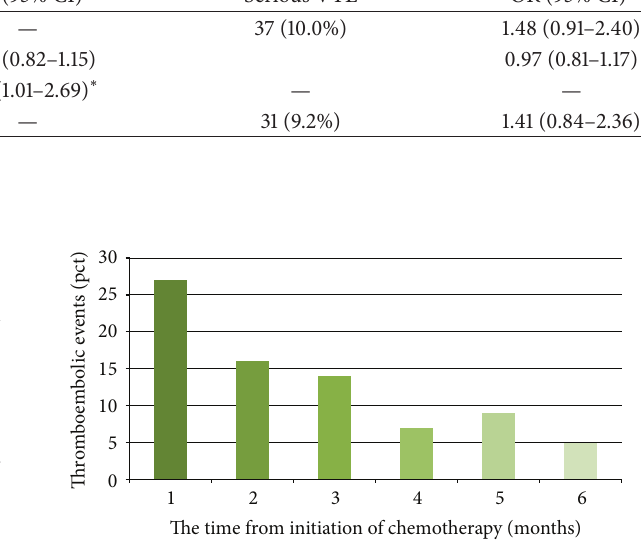
Figure 1: The occurrence of thromboembolic events after the start of